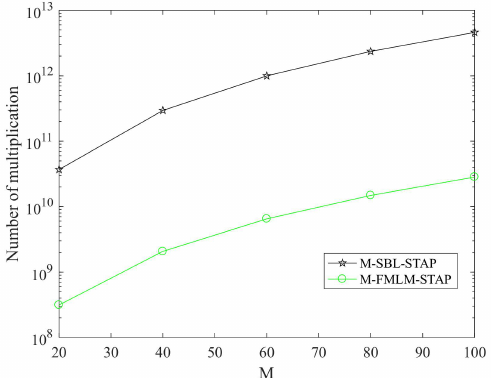
Figure 1. Computational complexity versus the number of pluses for a single